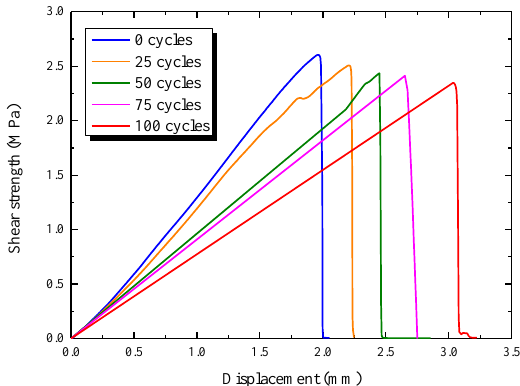
0.0 0.5 Figure 11. Typical curves of shear test under di ff erent freeze-thaw Figure 11. Typical curves of shear test under different freeze-thaw cycles.